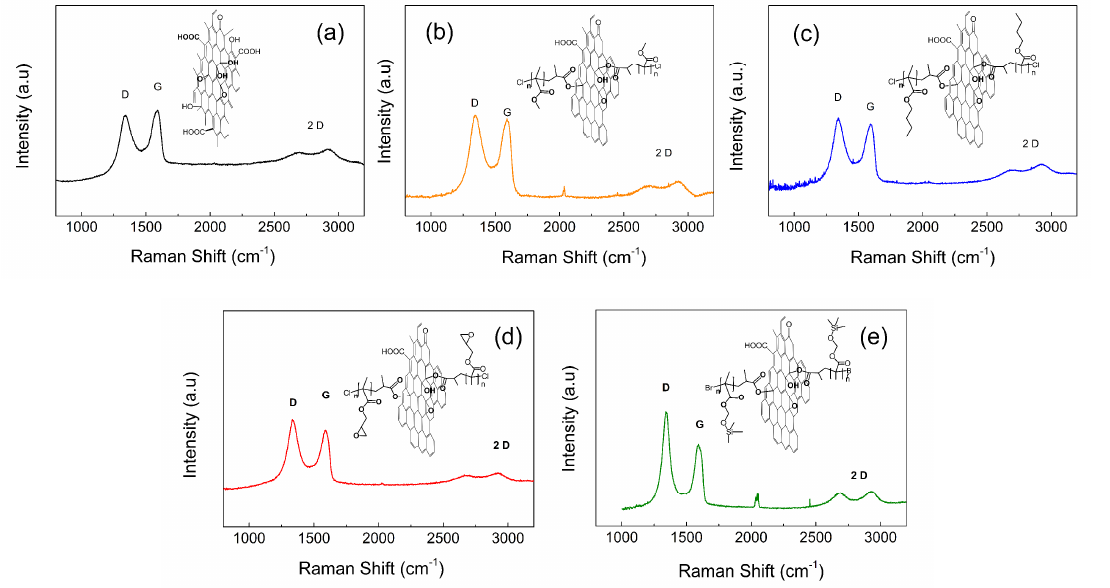
Figure 4. Raman spectra of: ( a ) the neat GO, ( b ) GO-PMMA, ( c ) GO-PBMA, ( d ) GO-PGMA, ( e ) GO-PHEMATMS.